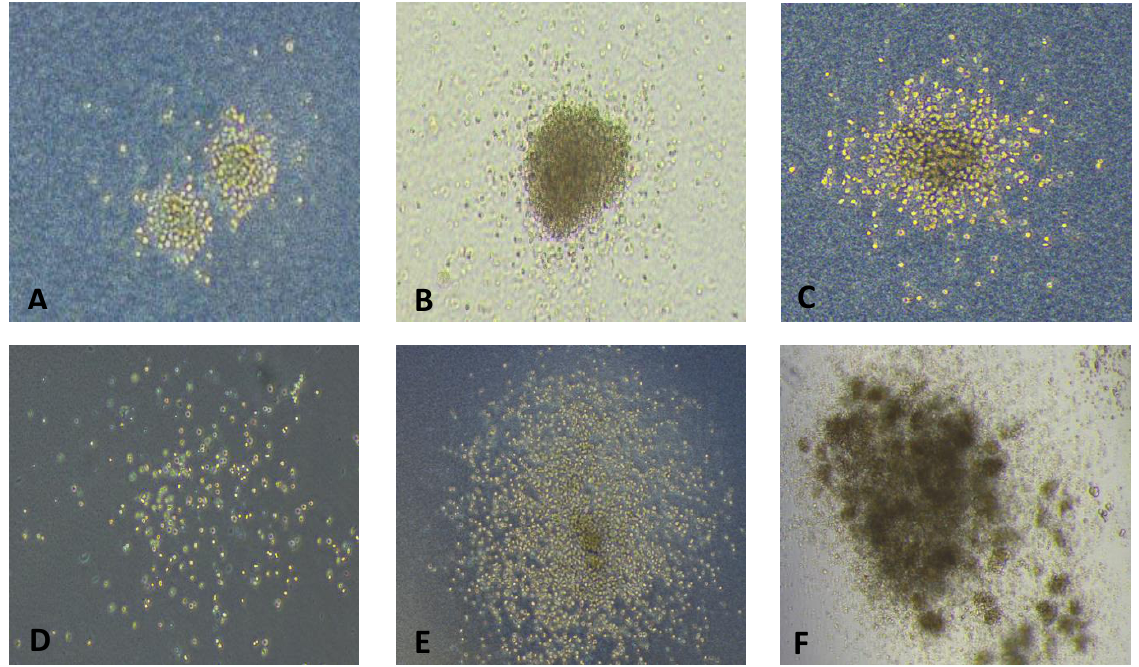
Figure 1: Photographs representing the morphology of colonies for colony-forming units (CFUs) of respective progenitor. (A) : CFU-E (erythroid); (B) : BFU-E (Burst-forming unit erythroid); (C) : CFU-G (granulocyte); (D) : CFU-M (macrophage); (E) : CFU-GM (granulocyte/macrophage); (F) : CFU-GEMM (granulocyte /erythrocyte /macrophage /megakaryocyte) (Magnification: